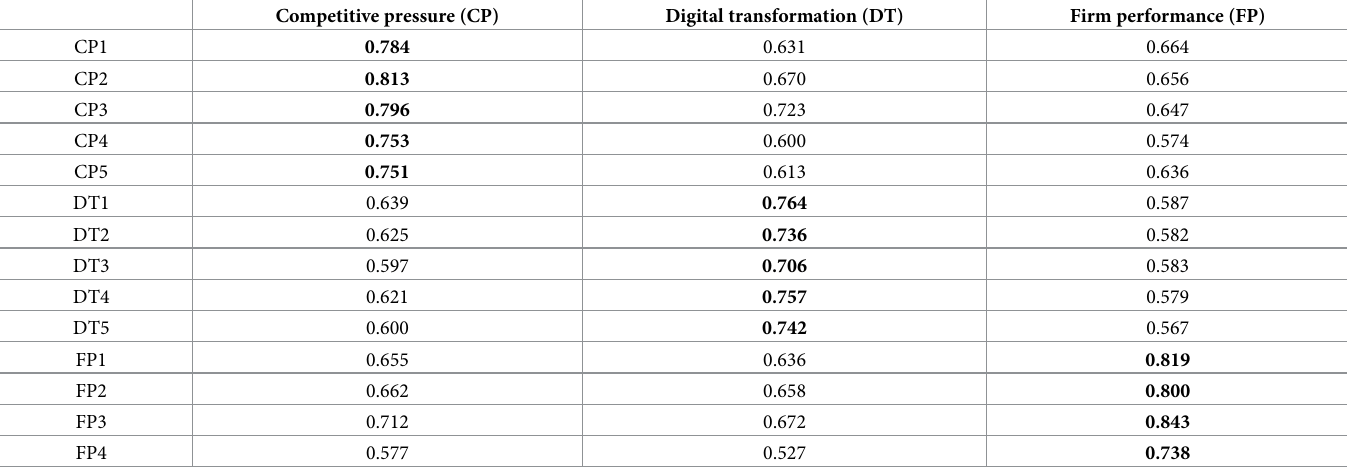
Table 3. Measurement, indicator loading, reliability and convergent validity. Construct Item AVE After the Covid-19 pandemic outbreak, your firm is under pressure from competitors to adopt digital transformation. After the Covid-19 pandemic outbreak, some of your competitors have already started digital transformation. After the Covid-19 pandemic outbreak, percentage of competitors in your industry that have conducted digital transformation is high. After the Covid-19 pandemic outbreak, percentage of competitors in your industry that have conducted Internet-based selling or servicing is high. After the Covid-19 pandemic outbreak, the level of rivalry among businesses in the same industry is fierce. After the Covid-19 pandemic outbreak, many new business processes built on technologies such as big data, cloud, mobile and social media platform. After the Covid-19 pandemic outbreak, the digital technologies such as social media, big data, cloud and mobile technologies are integrated to drive change. After the Covid-19 pandemic outbreak, the business operations are shifting toward making use of digital technologies such as big data, cloud, mobile and social media platform. After the Covid-19 pandemic outbreak, your firm develops digital products and services. After the Covid-19 pandemic outbreak, supporting communication of commercial and business information through digital technologies (such as big data, cloud computing, mobile and social platforms). Firm performance [21,78] After the Covid-19 pandemic outbreak, the growth is more as compared to competitors. After the Covid-19 pandemic outbreak, customer satisfaction of your company is better than that of key competitors. After the Covid-19 pandemic outbreak, quality development of your company is better than that of key competitors. After the Covid-19 pandemic outbreak, responsiveness of your company is better than that of key competitors.